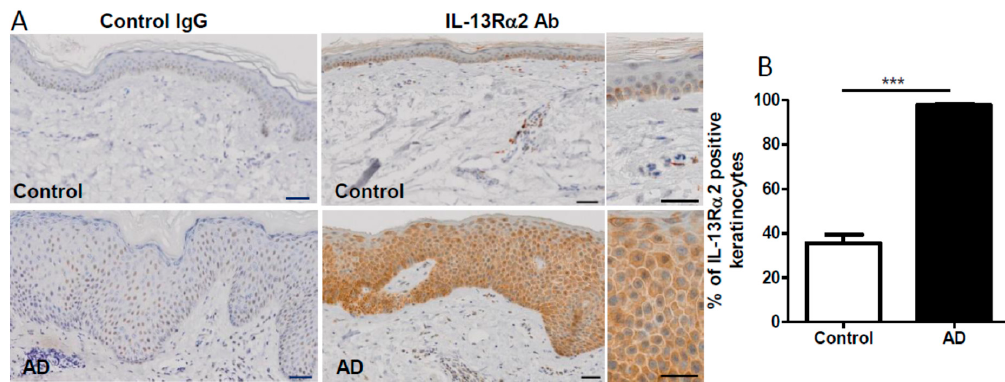
Figure 6. Immunohistochemical analysis for IL-13R α 2 expression. Control normal skin and lichenified lesional AD skin were immunostained with control IgG and anti-IL-13R α 2 antibody ( A ). The percentage of IL-13R α 2 positive keratinocytes was calculated in 11 normal skin and 11 AD skin samples ( B ). Data is shown as the mean ± SEM. *** p < 0.001. Scale bar: 50 µm.